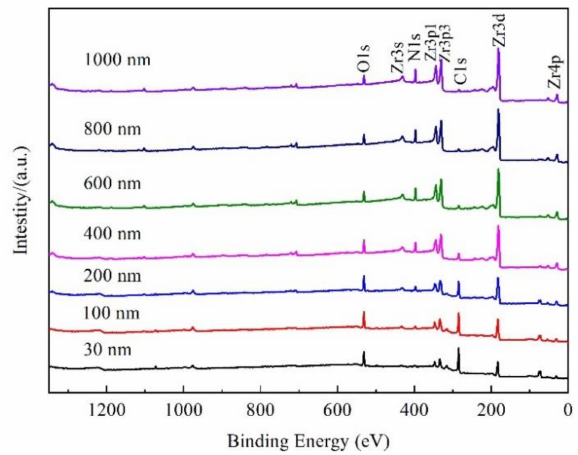
Figure 6. Full XPS spectrum of nitride film with sputtering